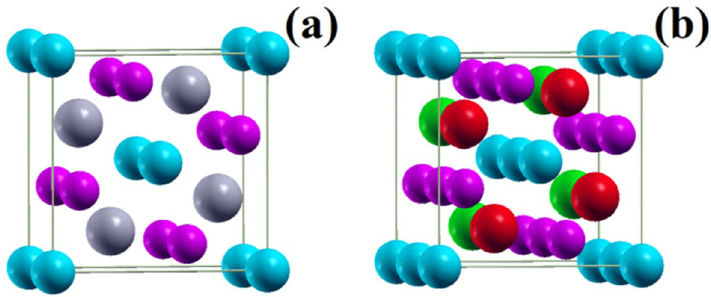
Figure 1. ( a ) Crystal structure. Gray, blue, and purple spheres represent the RE, Mg, and Ge atoms, respectively. ( b ) AF ordering of the RE 3+ ions (green spheres represent spin up and red spheres spin down).